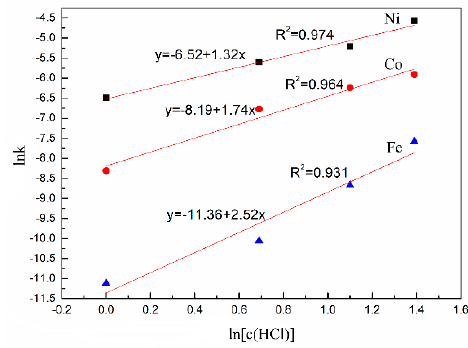
− ln c(HCl) of Ni, Co, and Fe. Minerals 2020 , 10 , x FOR PEER REVIEW